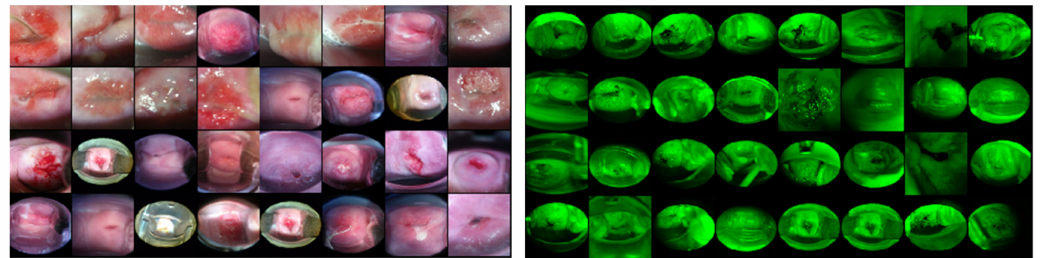
Figure 7. Validation examples of Deep SVDD approach. Left images are predicted as cervix in the validation set. Right images predicted as non-cervix images, though all of the images shown are cervix image samples with “green filter” applied.